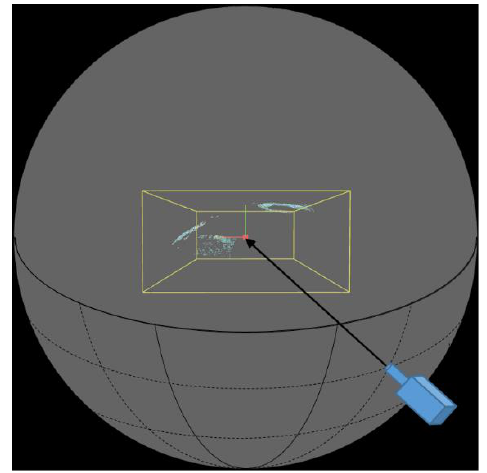
Figure 11 Camera displacement on the sphere by only considering bottom-up